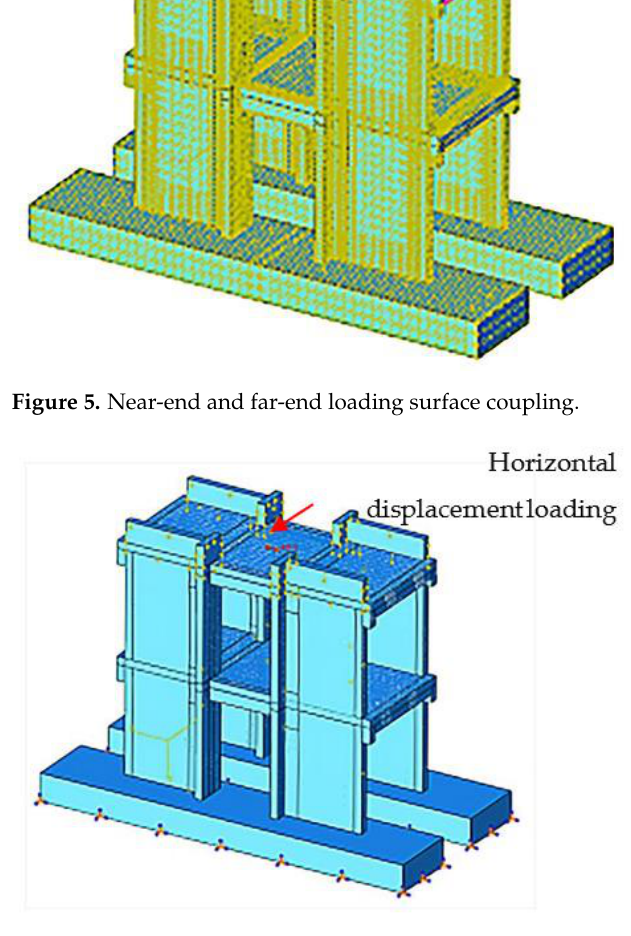
Figure 6. Low cycle repeated horizontal displacement loading.